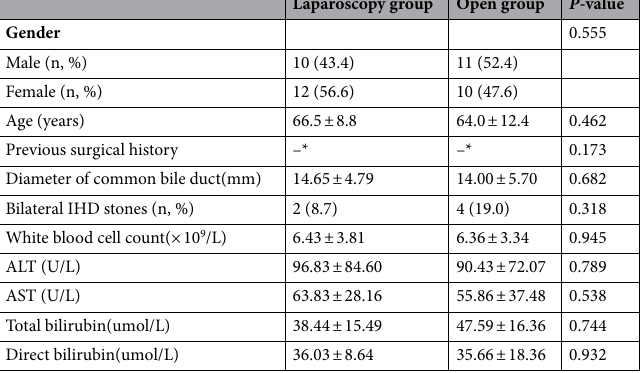
Laparoscopy group Open group P